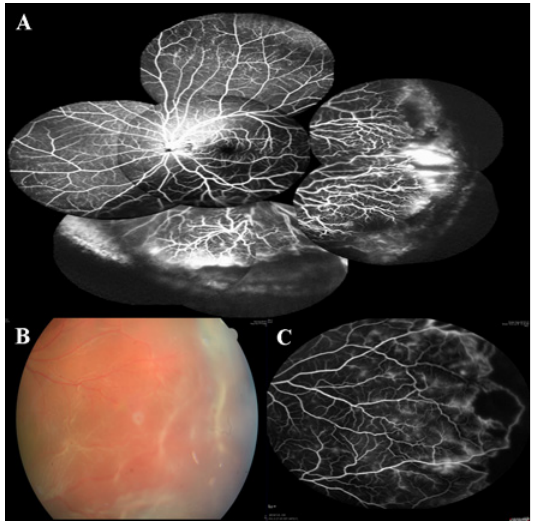
Fig 2. Color fundus and FA pictures of group 2 eyes (A) Fluorescein angiography of an eye with group 2 retinal vasculature. Note there is an abrupt cessation of temporal and lower peripheral retinal vasculature, leaving a wide area of peripheral non-perfusion. Marked leakage is noted at the temporal and lower detached retina. Some microaneurysms are noted in the nasal peripheral, attached retina. (B) Magnified color fundus showing lattice degeneration at temporal aspect in the same patient. (C) Fluorescein angiography at the same location showing the lattice degeneration situated just beyond the vascular cessation. Terminal dilatation, vascular tortuosity and telangiectatic vessels were also